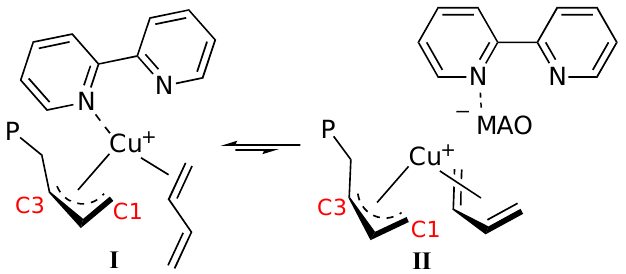
Figure 5. Sketch of the possible equilibrium between form ( I ) and form ( II ).